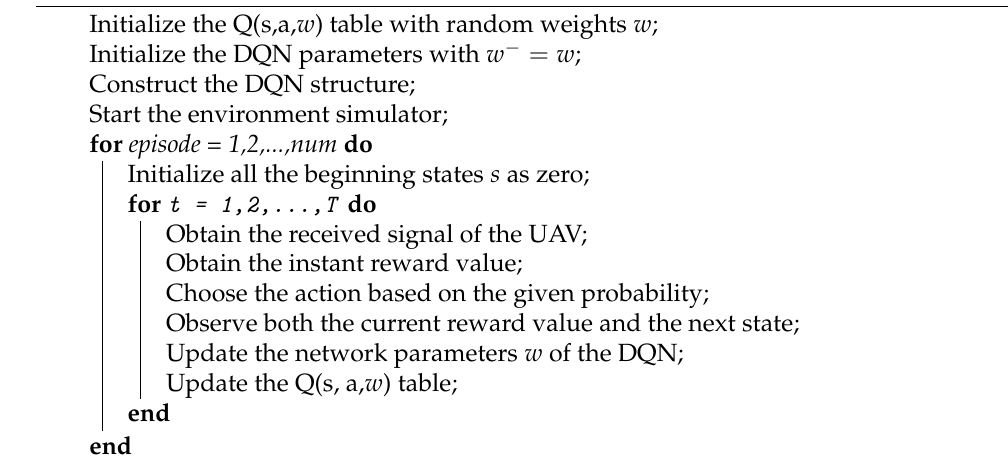
Algorithm 1: Pseudocode for DQN-Based Training